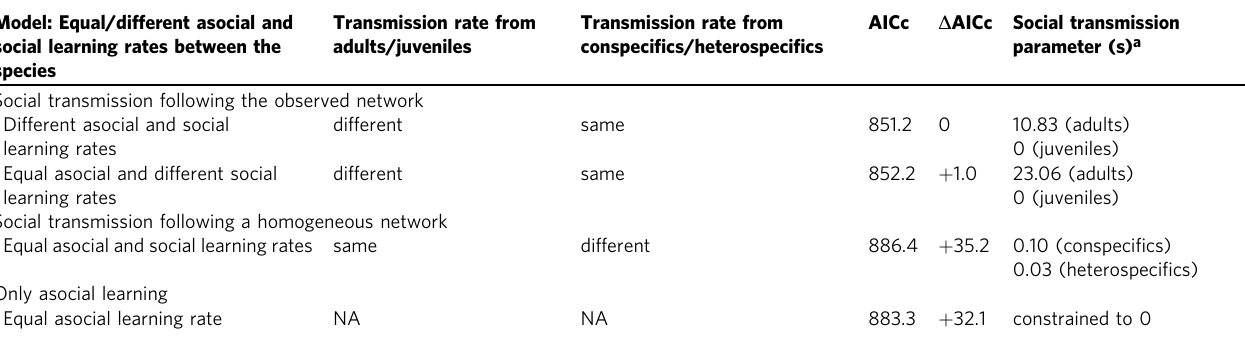
Table 3 Summary of the best supported NBDA models of reversal learning with social transmission following the observed (models with Δ AIC < 2) or homogeneous network, or with asocial learning only. Model: Equal/different asocial and social learning rates between